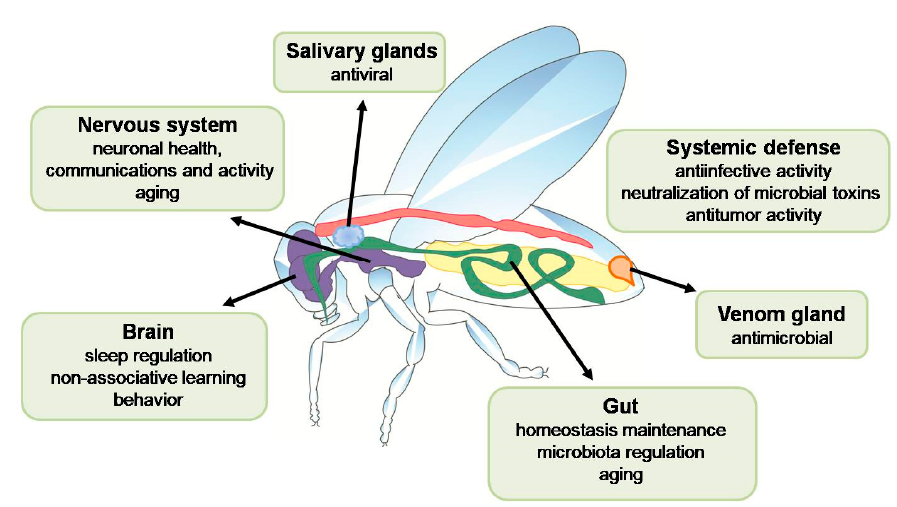
Figure 2. Di ff erent functions of AMPs in insects. Figure 2. Different functions of AMPs in